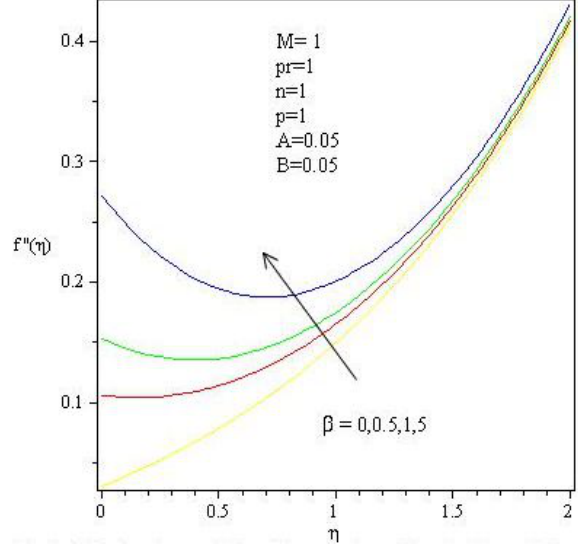
Fig. 10: Combined profile of flow and velocity for different values of M and p = 1, M = 1.5, Pr = 1, A = 0.5, B = 0.5, n = 1